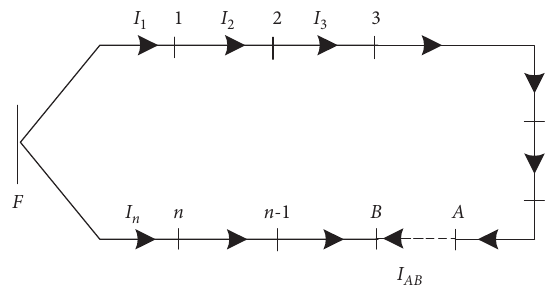
Figure 1: The simple loop distribution